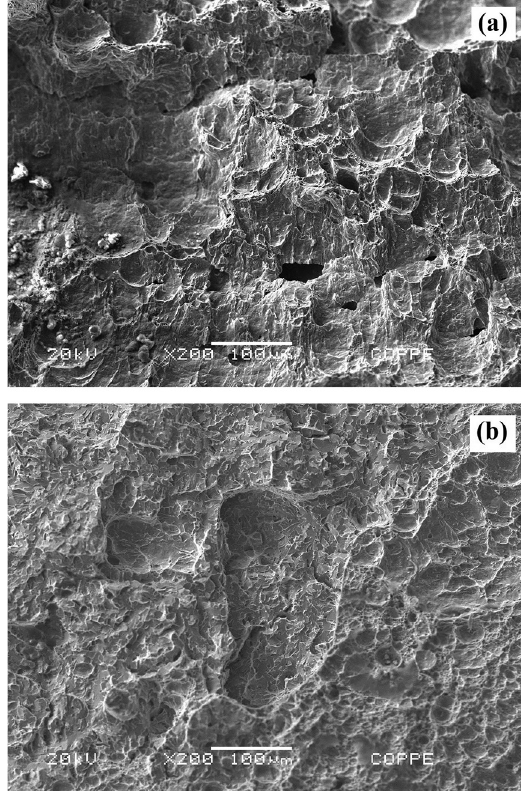
Figure 9: SEM of fracture surface after Charpy tests of base metal: (a) as-received, (b) hydrogenated.